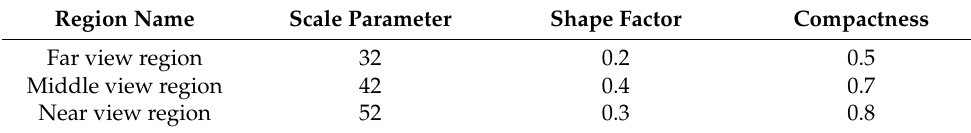
Table 4. Optimal segmentation parameters for near, middle and far view regions.